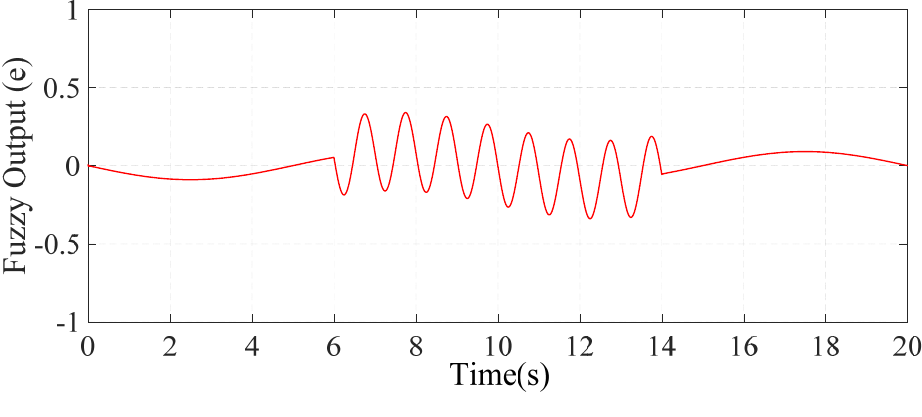
Figure 9. FLC output